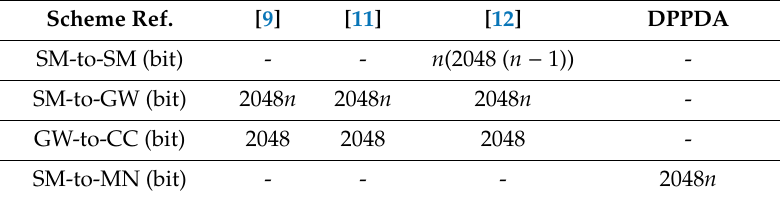
Table 4. Comparing communication cost between the proposed scheme and other schemes. Scheme Ref.